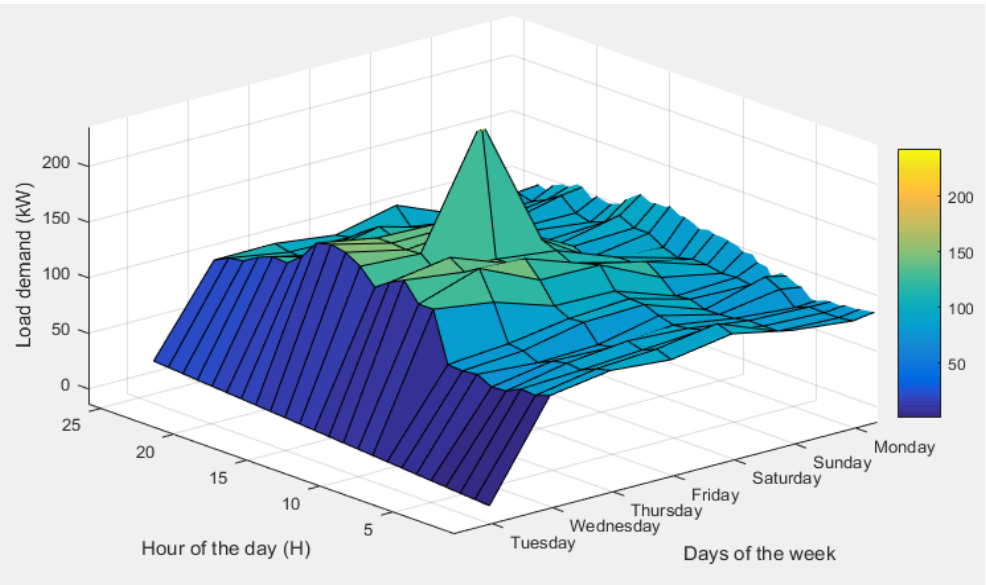
Figure 6. Load profile of engineering building 2 – 7 from 8 May 2018 to 14 May 2018. Table 4. Power consumption of engineering building 2 – 7 (8 May 2018~14 May 2018).